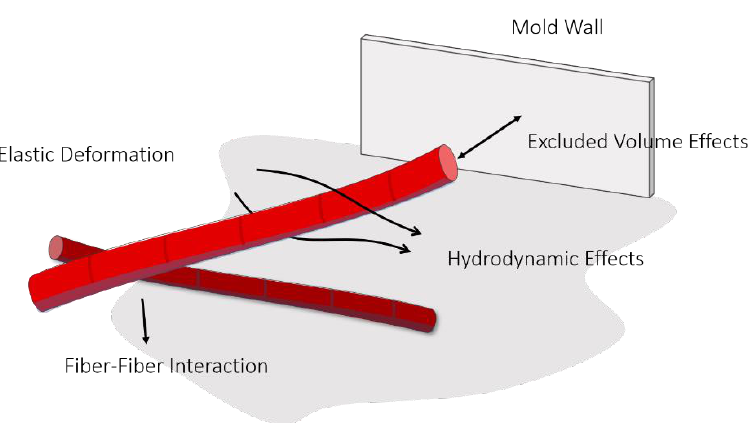
Figure 1. Particle level simulation: modeling single fiber and macroscale interactions.